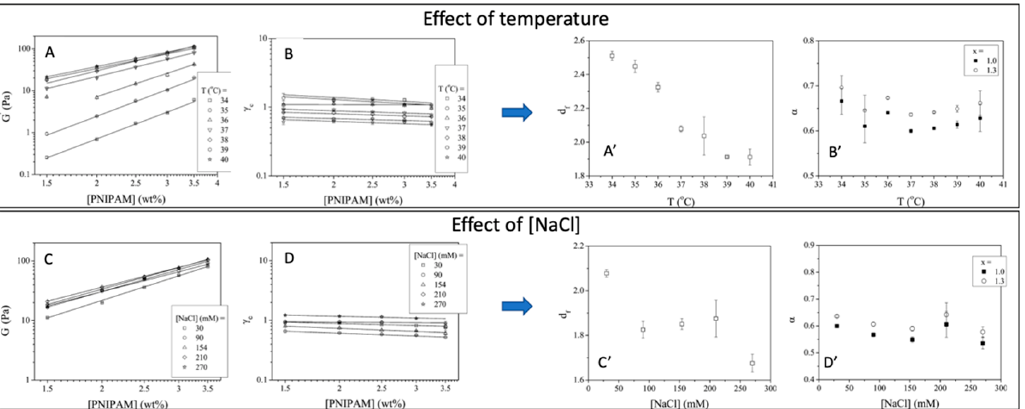
Figure 5. Graphs on the left: double-logarithmic plots of the elastic modulus G ′ ( A , C ) and critical strain γ c ( B , D ) of the hydrogels gelled at various temperatures and various [NaCl], as a function of microgel concentration. Graphs in the right: ( A’ , C’ ) fractal dimension, df, and ( B’ , D’) ) the parameter, α , of the in situ-formed gels gelled at various temperatures calculated using the Wu and Morbidelli model. Adapted with permission from [118] , copyright 2012 American Chemical Society.